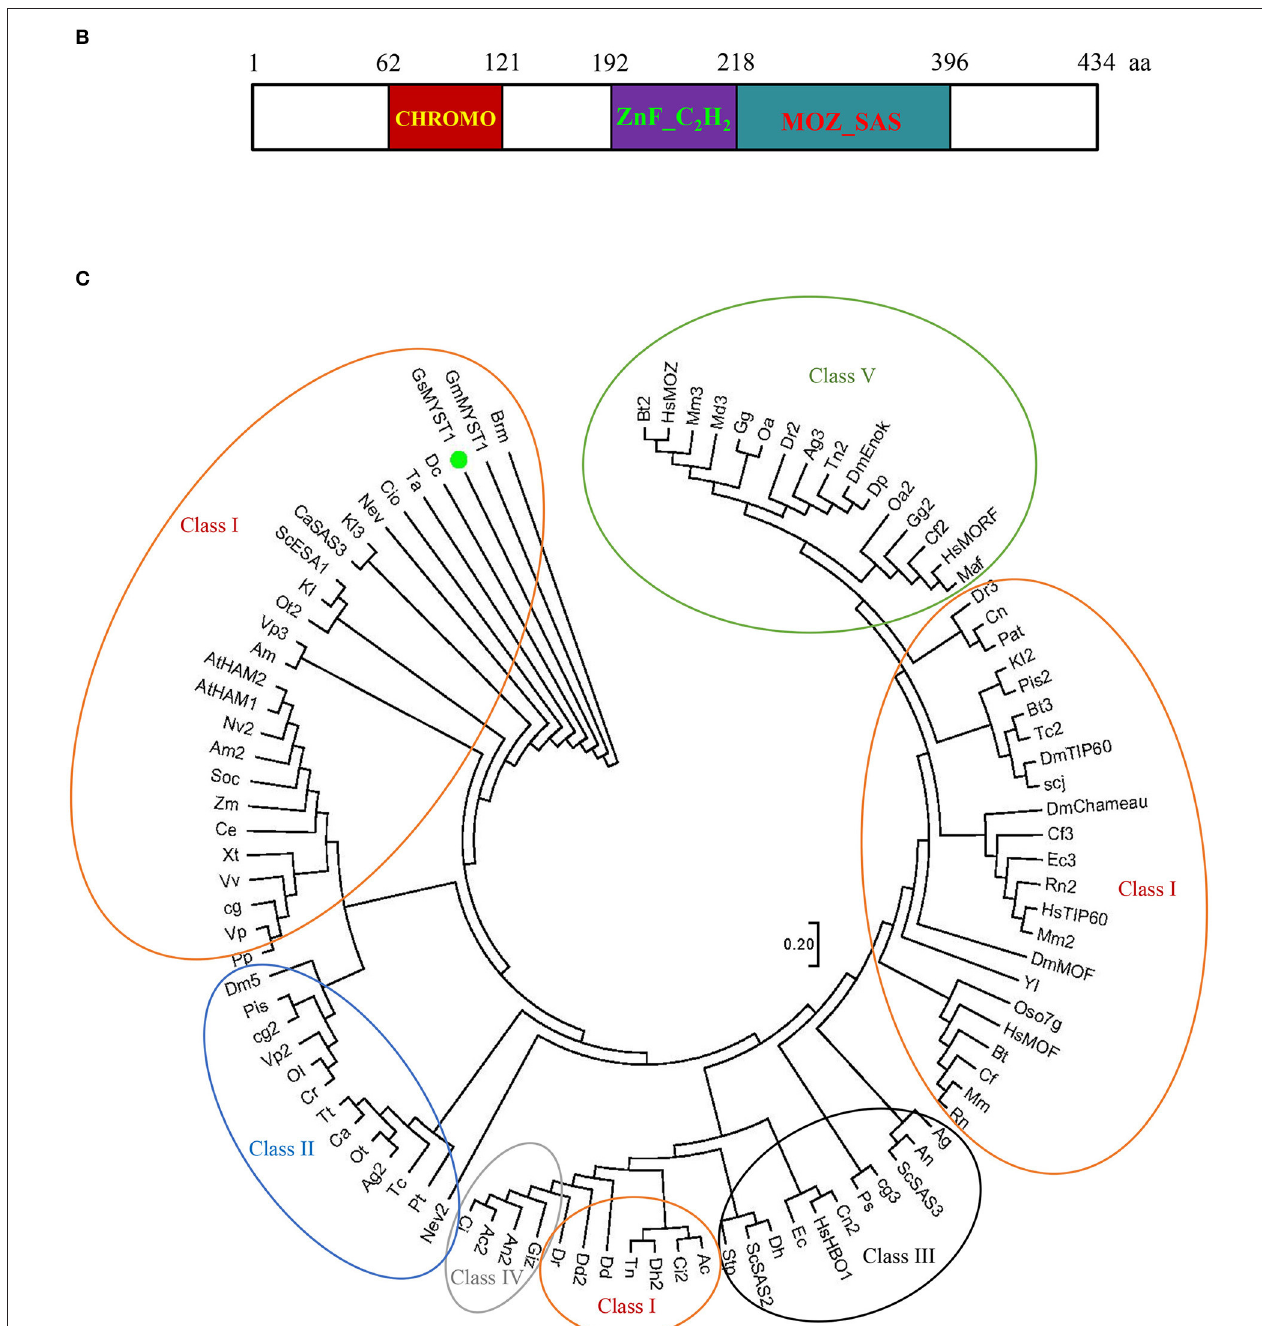
FIGURE 1 | Sequence, structural, and phylogenetic analyses of GsMYST1. (A) The sequence alignment generated by DNAMAN. The protein sequences of the selected MYST family histone acetyltransferases were obtained from Genbank or Phytozome. The accession numbers are listed as follows: AtHAM1(At5g64610), AtHAM2(At5g09740), GsMYST1-like(XP_028228732.1), GmMYST1(XP_003522879.1), ApMYST1(XP_027341323.1), CcMYST1(XP_029129210.1), LaMYST1-like(XP_019431040.1), VrMYST1(XP_014499610.1), VaMYST1(XP_017425612.1), MtMYST2(XP_003598140.2), CaMYST2-like(XP_004499615.1), and GrMYST1-like1(XP_012451505.1). (B) Structural analysis of GsMYST1 protein. (C) Molecular phylogenetic analysis of the MYST family of histone acetyltransferase (HAT) taxa. The evolutionary history was inferred using the maximum likelihood method based on the JTT matrix-based model. The tree with the highest log likelihood ( − 71798.64) is shown. The initial tree for the heuristic search was obtained automatically by applying Neighbor-Join and BioNJ algorithms to a matrix of pairwise distances estimated using a JTT model and then selecting the topology with a superior log-likelihood value. The analysis includes 100 protein sequences. All positions containing gaps and missing data were eliminated. There are a total of 310 positions in the final dataset. Evolutionary analyses were conducted in MEGA7. Representations of color circles: red: Class I; blue: Class II; black: Class III; green: Class IV; orange: Class V.